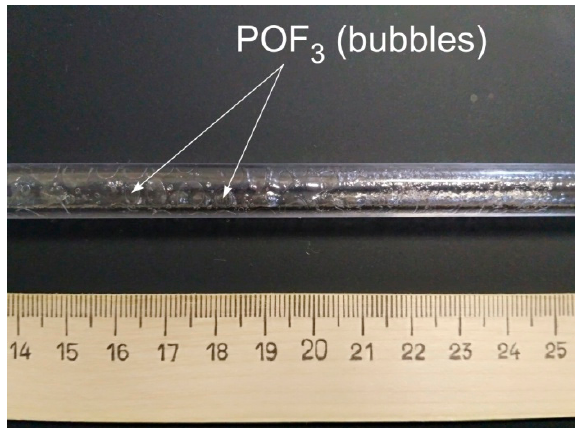
Figure 1. The photo of a tubular preform with the inner layer of Er–Yb–fluorophosphosilicate (FPS) glass fabricated by the standard modified chemical vapor deposition (MCVD) all-gas-phase deposition technique. The source of bubbles in FPS glass is POF 3 .